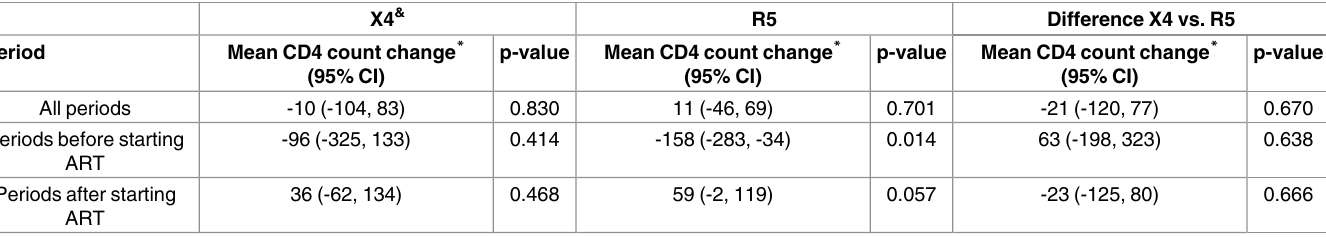
Table 3. Interaction between effectsof tropism and ART status on CD4 slope from fitting a linear mixed model with random intercept and